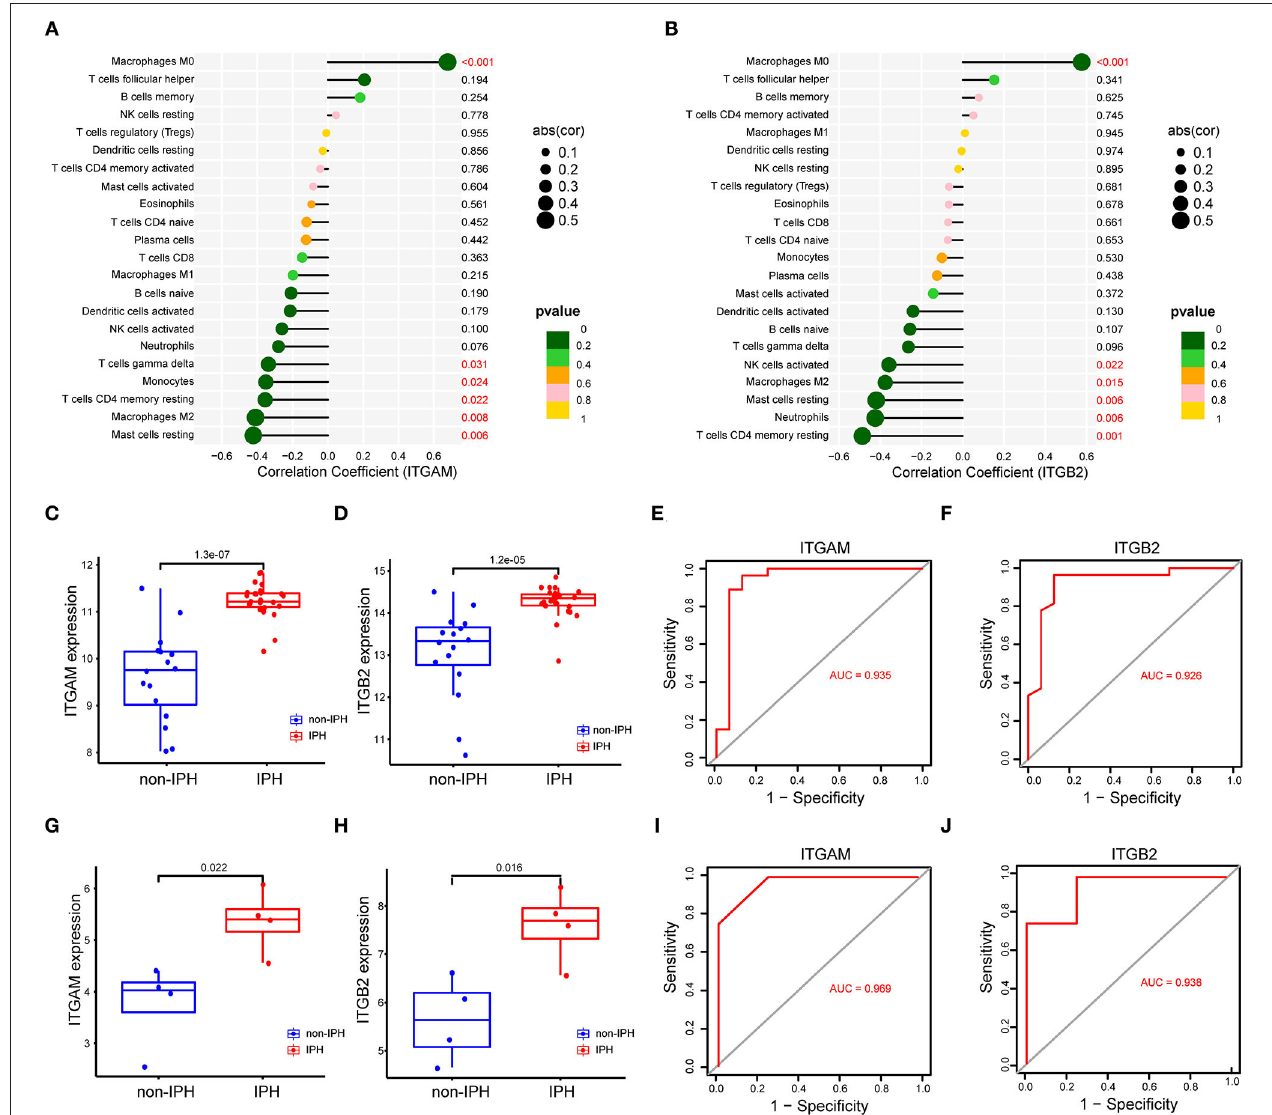
FIGURE 7 | (A,B) Correlation between the hub genes ( ITGAM, ITGB2 ) and infiltrating immune cells. The size of the dots represents the strength of the correlation between genes and immune cells, and the color of the dots represents the p -value. p < 0.05 was considered statistically significant. (C,D) The expression level of two genes between IPH and non-IPH samples in dataset GSE163154. (E,F) ROC curves for evaluating the accuracy of logistic regression analysis of dataset GSE163154. (G,H) The expression level of two genes between IPH and non-IPH samples in validation dataset GSE120521. (I,J) ROC curves for evaluating the accuracy of logistic regression analysis of validation dataset GSE120521. ROC, receiver operating